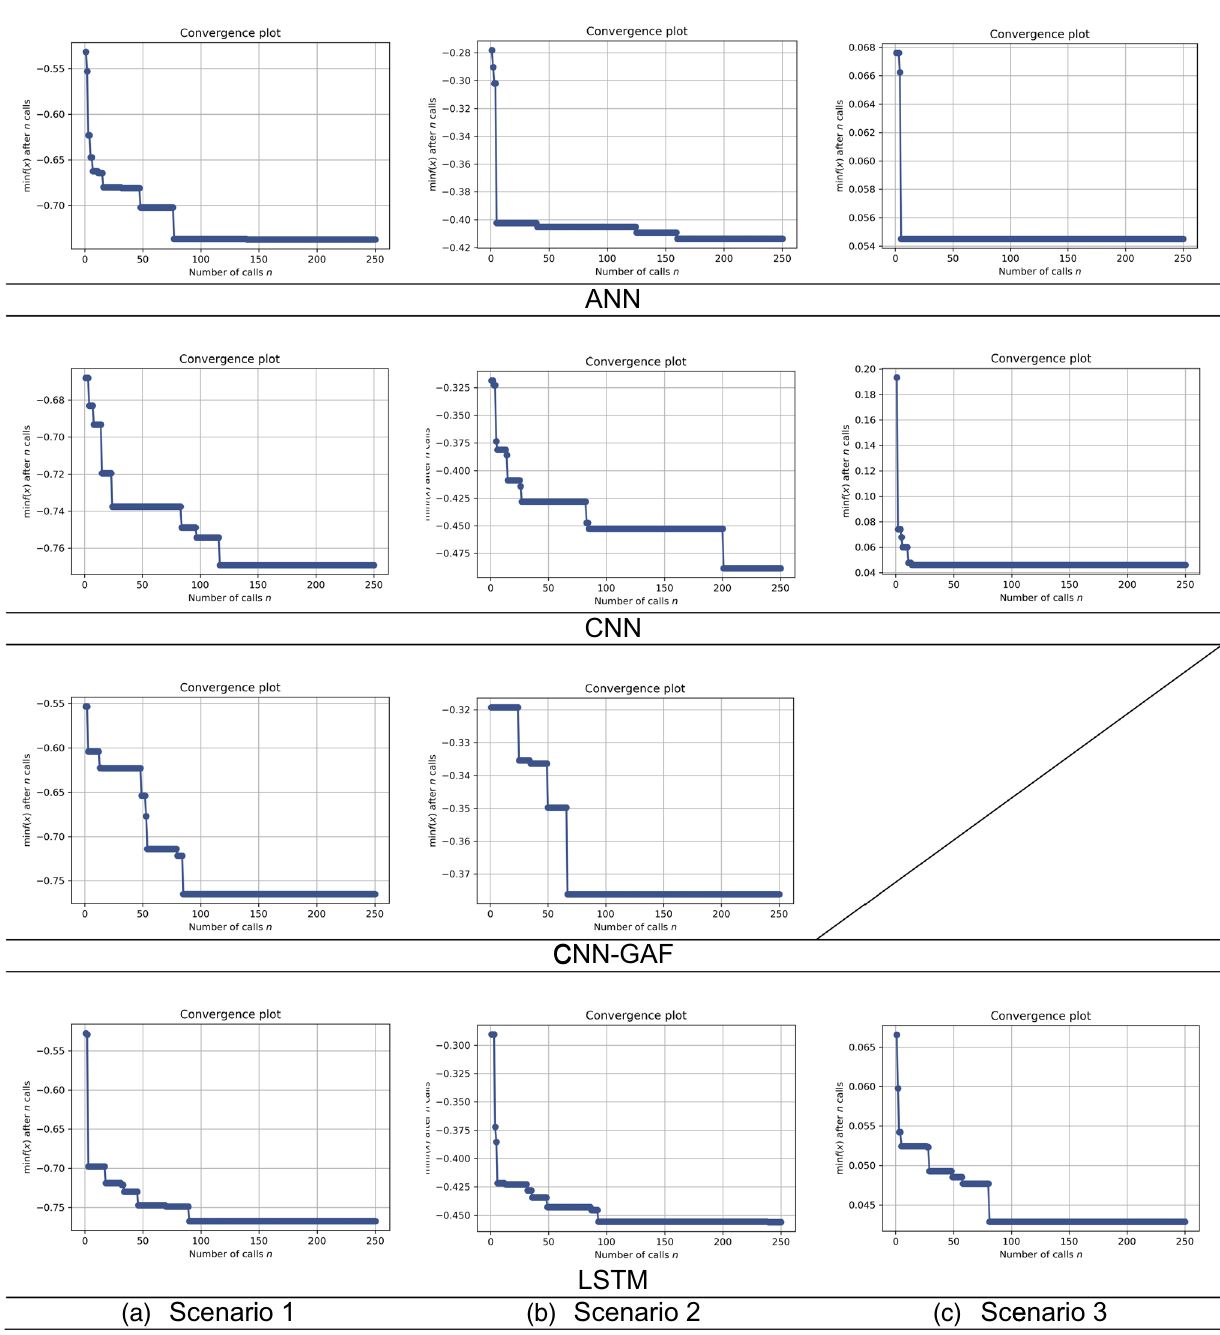
Fig. 7 The convergence graph of the hyperparameter tuning process with objective function of streamflow forecast accuracy as a function to the total number of iterations using Bayesian